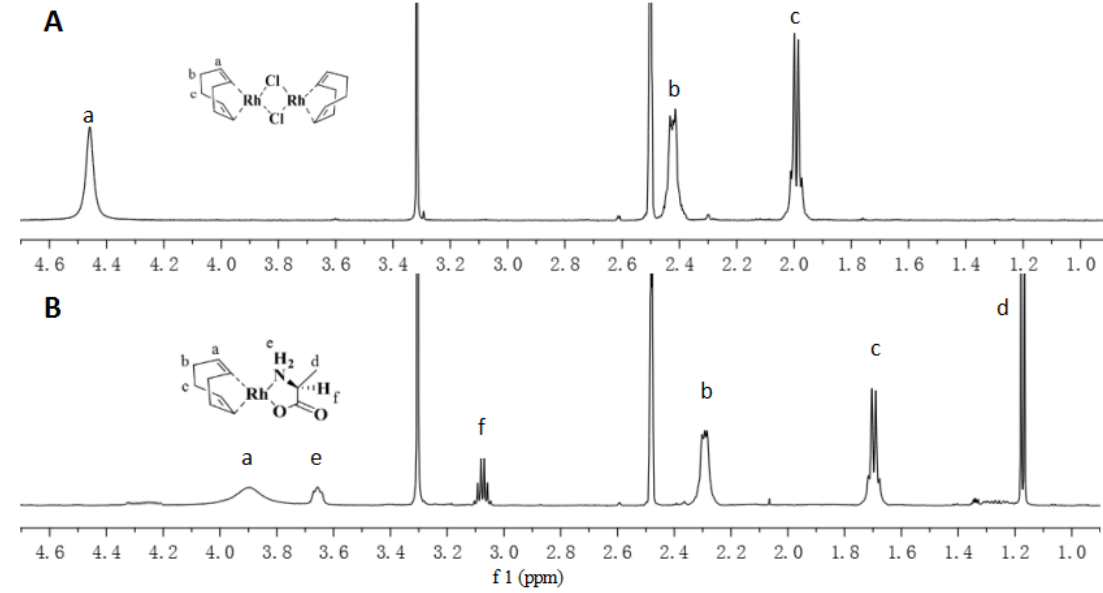
Figure 1. ( A ) 1 H NMR spectra of [Rh(cod)Cl] 2 and ( B ) [Rh( L -alaninate)(cod)] in DMSO- d 6 at 25